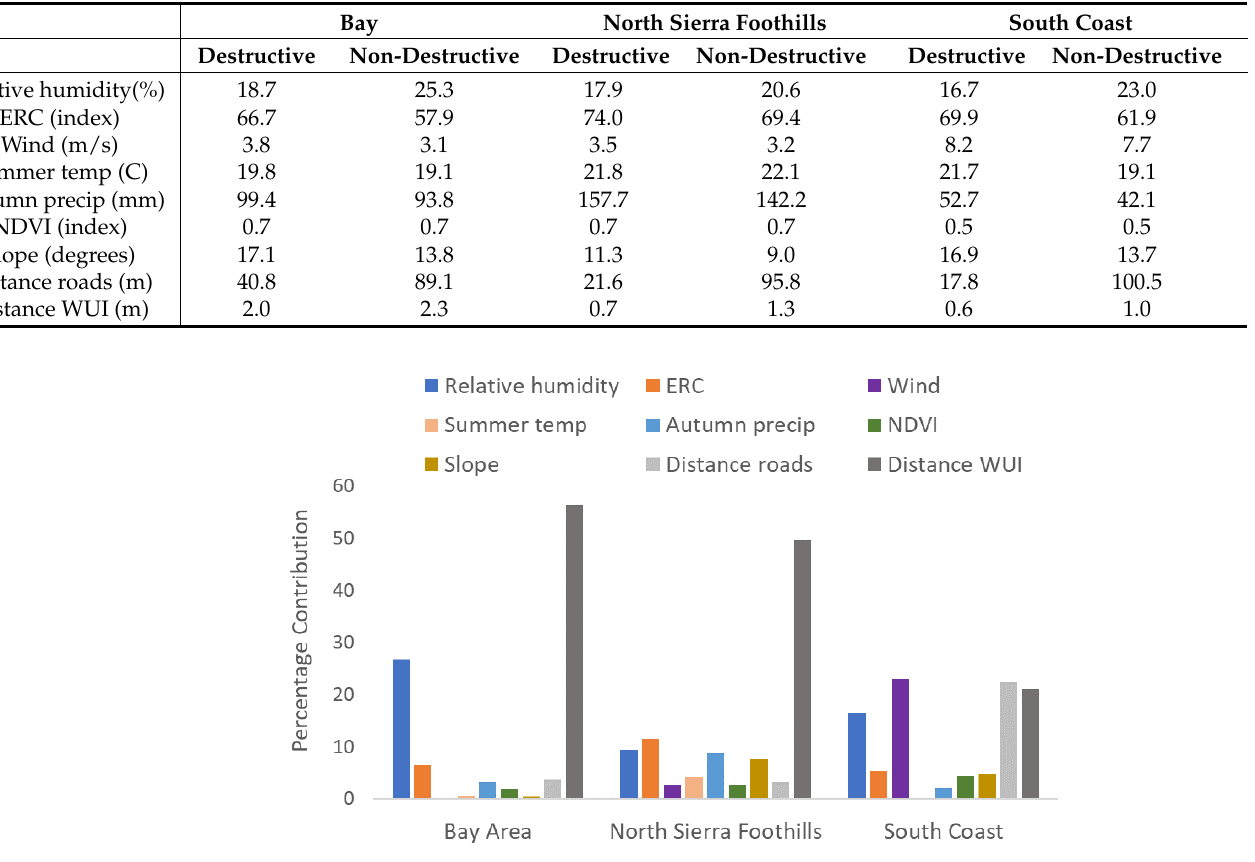
Figure 4. Relative independent variable importance explaining the difference between destructive and non-destructive wildfires ≥ 100 ha for three California regions from 2000–2018. Variables account for: weather (relative humidity, energy release component (ERC), and wind velocity) on the date that fires started, seasonal climate (summer temperature (summer temp), autumn precipitation (autumn precip, vegetation productivity (normalized difference vegetation index (NDVI) in the year before the fire, slope, distance to roads, and distance to the Wildland Urban Interface (WUI) in the year 2000. In a multivariate framework, the distance to the WUI was again the most important variable for the two northern regions (Figures 5 and 6), although the thresholds separating destructive from non-destructive fires was different, with a longer-distance threshold for the Bay Area. In the Bay Area, relative humidity was the second most important split of the data, followed by NDVI on the day of the fire, slope, and wind velocity (Figure 5). No other variables were retained in the tree, and the AUC for the tree was 0.91. For the North Sierra Foothills, seasonal climate–autumn precipitation, followed by summer temperature, were the next most important splits of the data, with ERC being the third most important variable and no other variables retained for the tree (Figure 6). The AUC on training data for the North Sierra Foothills tree was 0.85. In Southern California, wind velocity on the day the fire started was the most important variable distinguishing destructive from non-destructive fires in a multivariate framework (Figure 7). The only other two splits